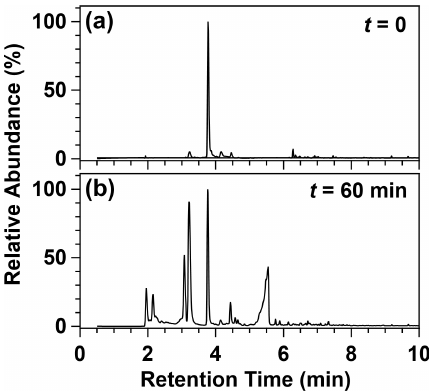
Figure 5. Arrhenius plot for the rate coefficient of the 2MB + OH reaction between 263 and 353K.